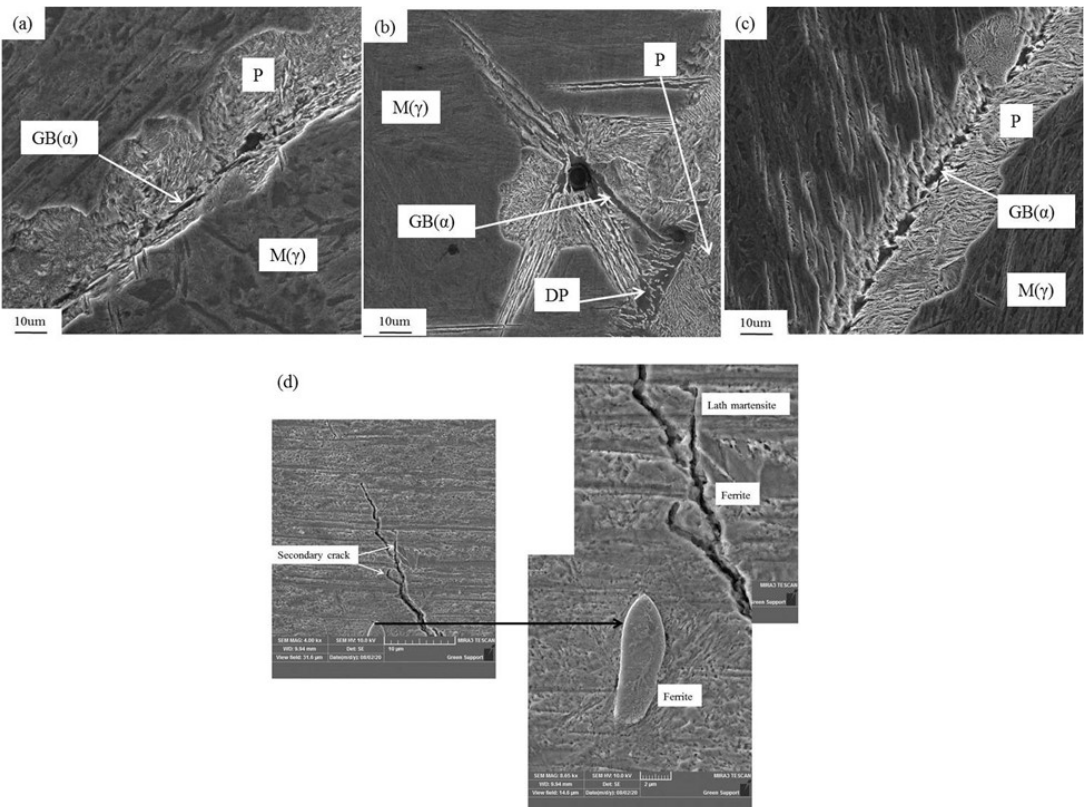
Figure 3. Microstructures of specimens, (a) At 3mm/120s, (b) At 3mm/180s, (c) Without SR and, (d) Crack morphology at 3mm/120s.